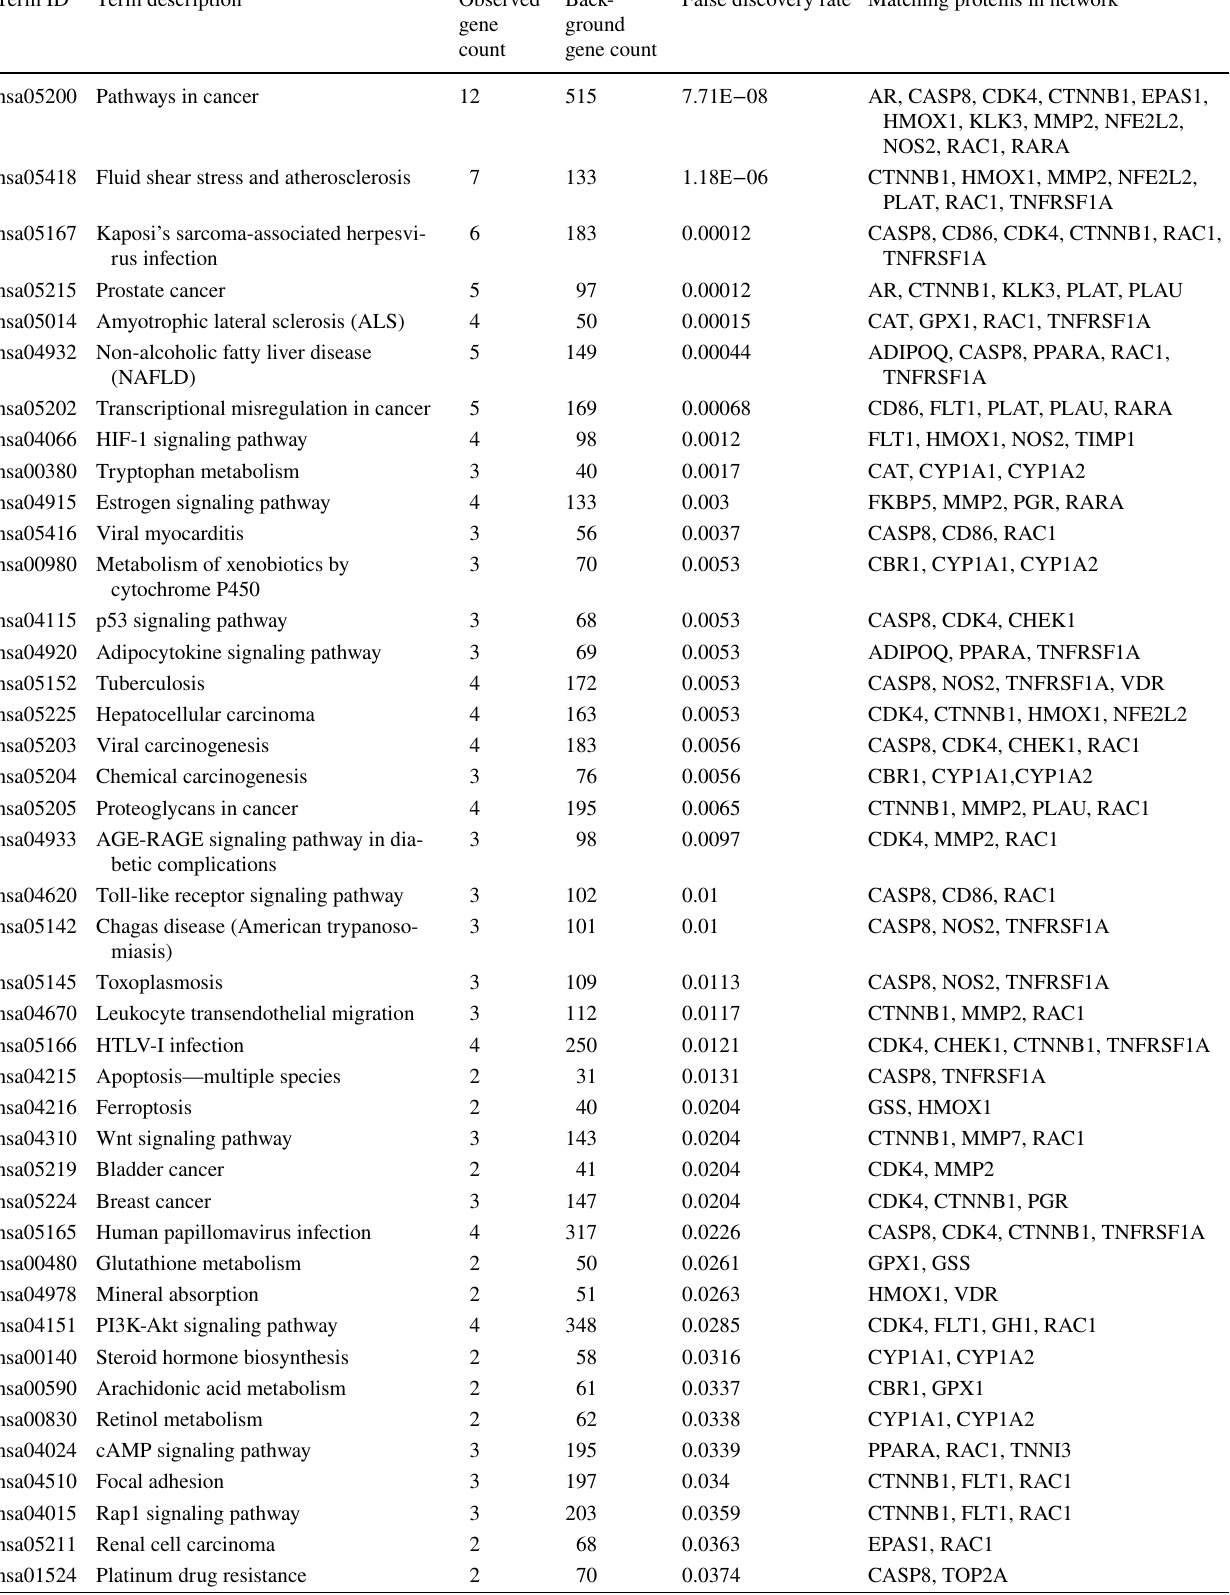
Table 2 Enrichment analysis of modulated proteins by the reported anthraquinone derivatives Term